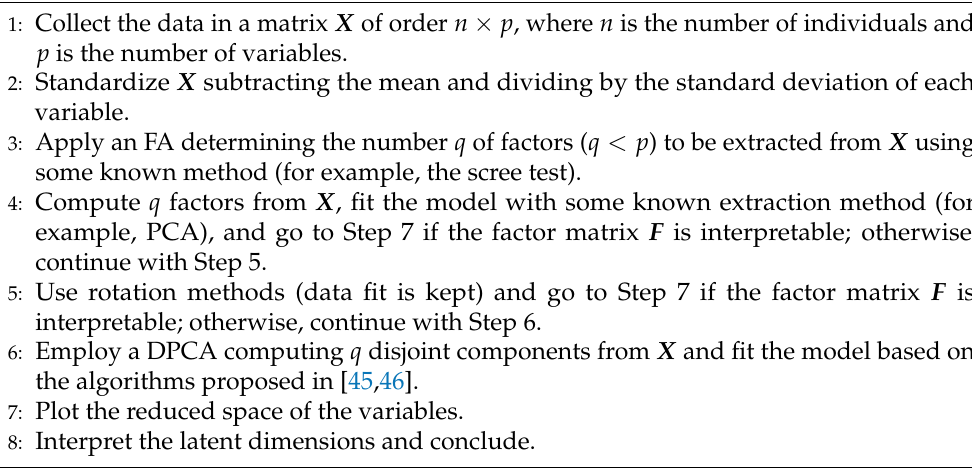
Algorithm 1 Method for dimension